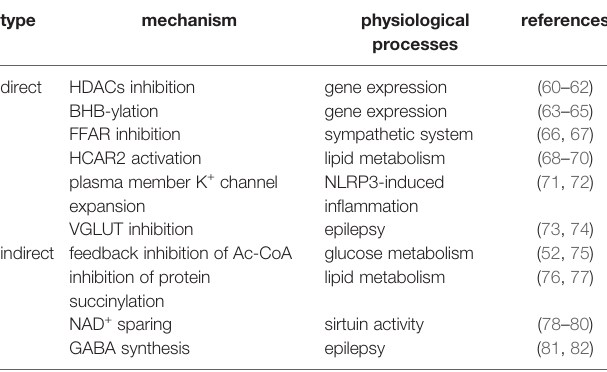
TABLE 1 | The roles of BHB as signal